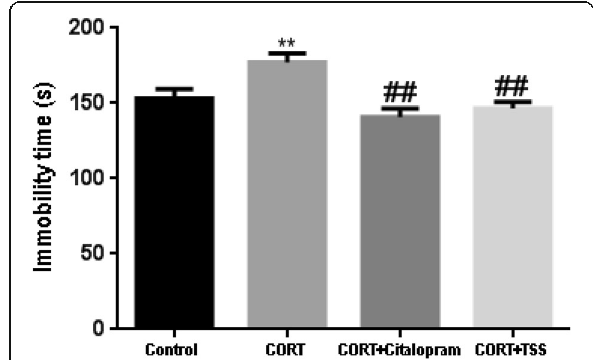
Fig. 6 Effects of TSS (25 mg/kg) and citalopram (10 mg/kg) in the FST in the chronic CORT treatment mice. Data were analyzed by one-way ANOVA followed by Student-Newman-Keuls test. Each bar represents the mean ± SEM ( n = 8 – 9). ** P < 0.01, as compared with the control group and ## P < 0.01, as compared with the CORT